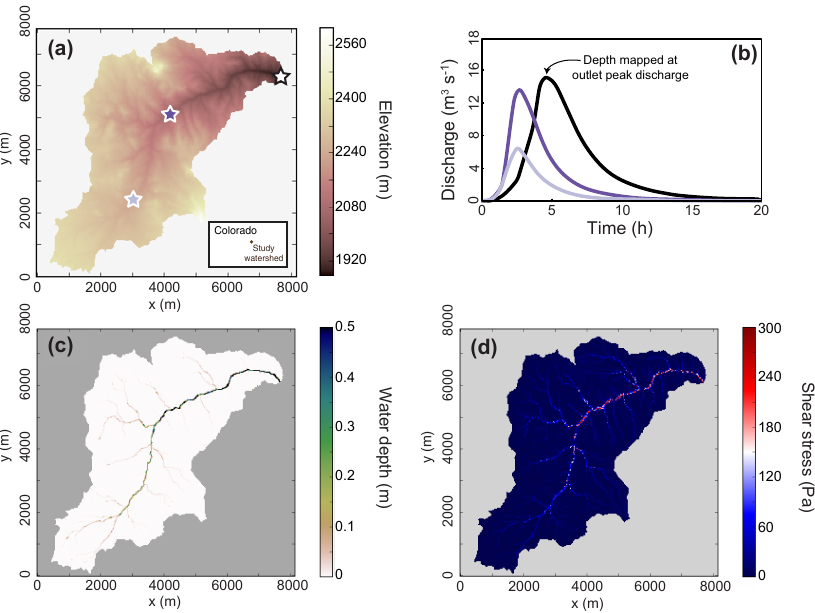
Figure 8. Results from the real landscape example. Panel (a) shows the topography of the Spring Creek watershed, and the inset notes the location of this watershed in central Colorado, USA. Panel (b) illustrates the hydrographs from three points within the main channel. The location for each hydrograph sampling site is shown in panel (a) , with the lightest color at the upstream, darkening in color towards the outlet. The delay in hydrograph peak is clearest between the outlet and upstream points. There is a delay between the upstream and midstream points, but it is difficult to detect at this scale. Panel (c) shows the water depth plotted at the time of the outlet hydrograph peak, as noted by the arrow in panel (b) . Panel (d) shows the local maximum shear stress value at each point over the duration of the model run. Note that the discontinuities in the shear stress figure are a result of the uneven bed topography and variations in the surface water slope linked to that